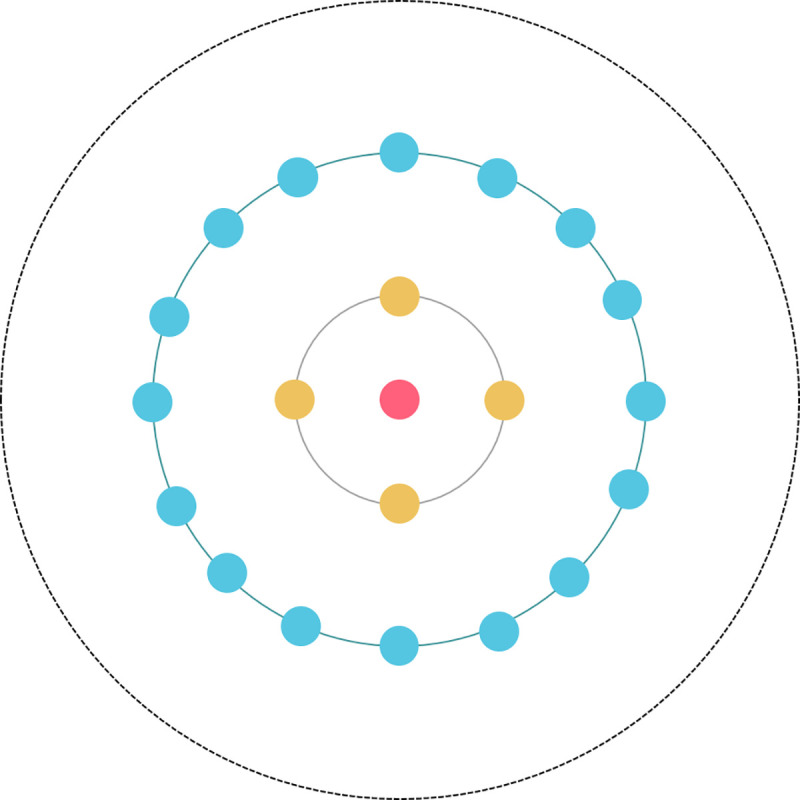
k-layer diffusion of potential field.